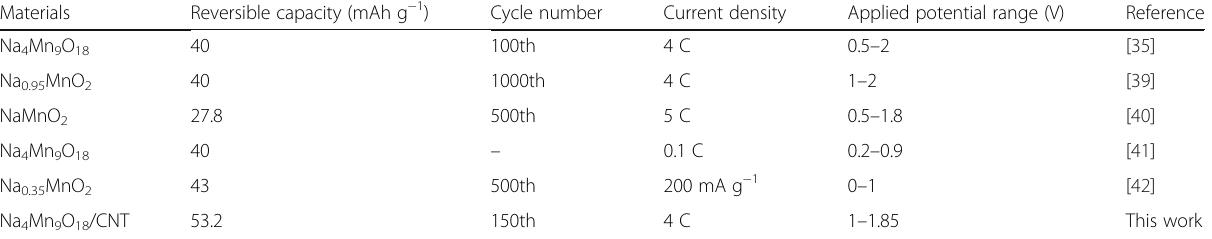
Table 2 Performance comparison of Na x MnO 2 -based cathodes for aqueous sodium-ion